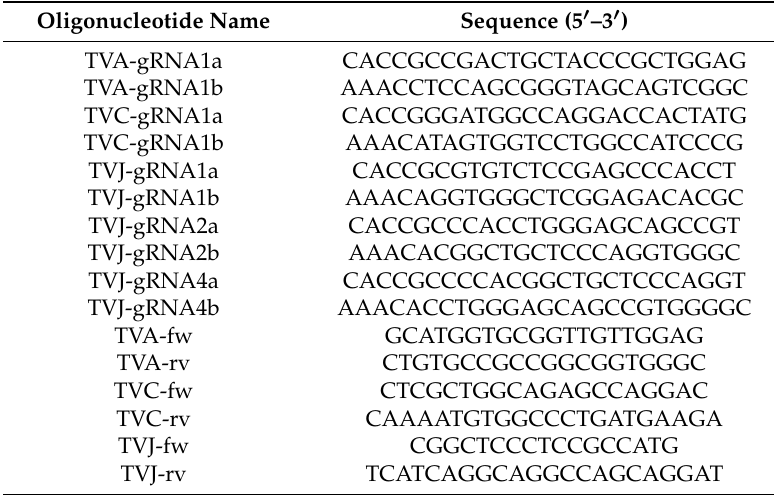
Table 1. Oligonucleotides used in this study. Oligonucleotide